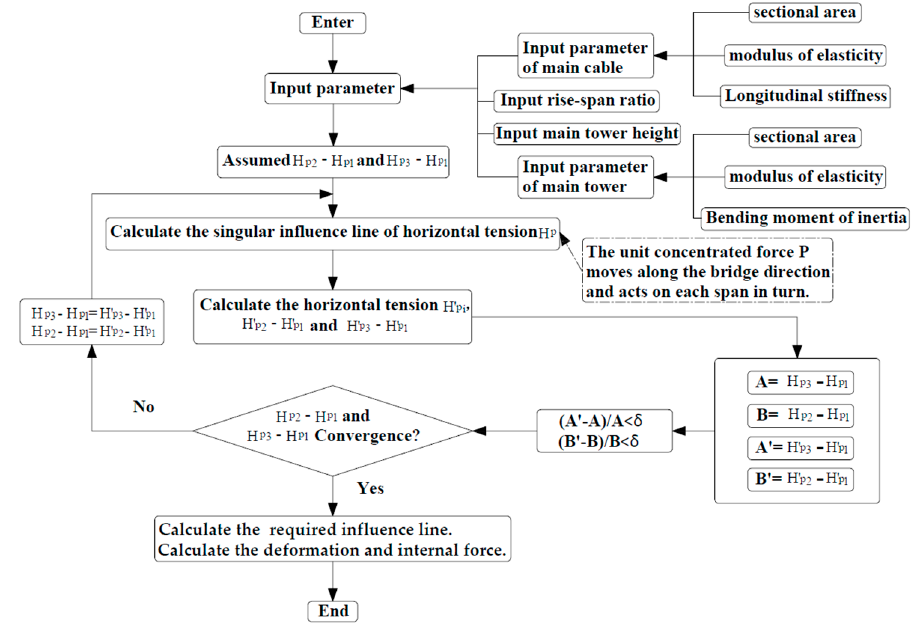
Figure 4. MATLAB calculation flow chart.